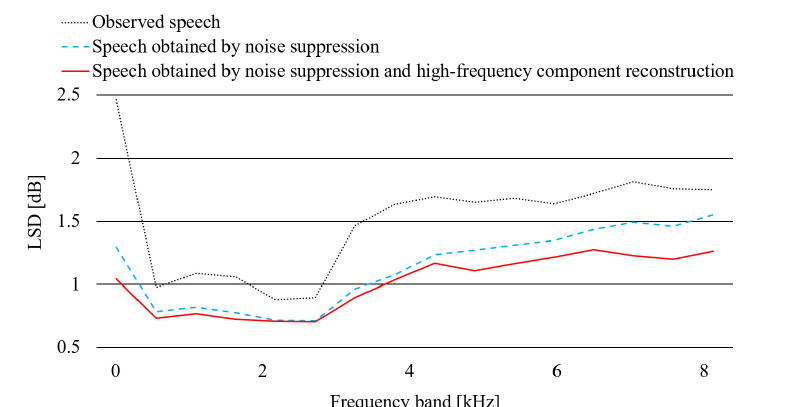
Figure 14. LSD of enhanced speech with each method at each frequency